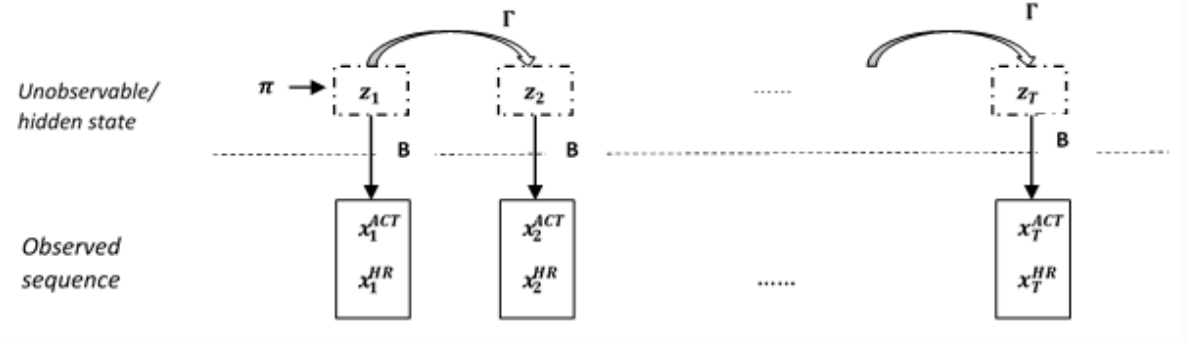
Figure 1. An illustration graph of the structure of multivariate hidden Markov